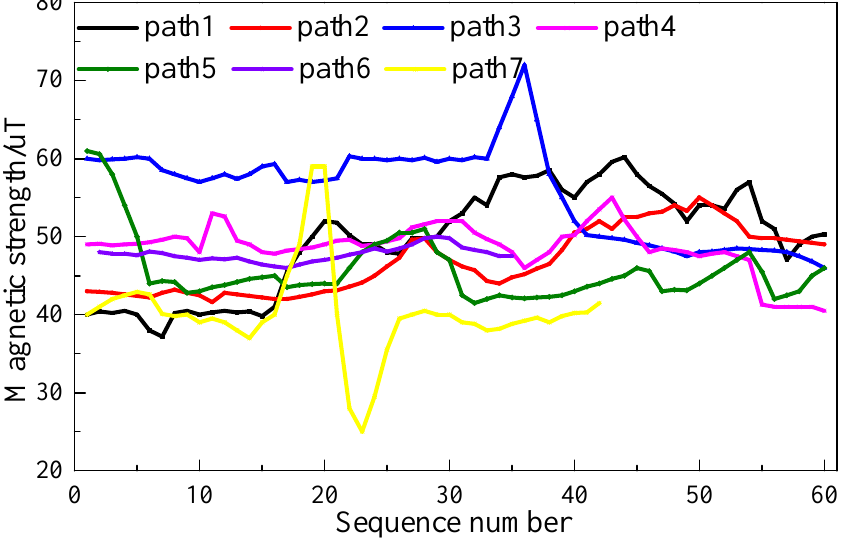
Figure 10. Comparison of indoor magnetic strength of different